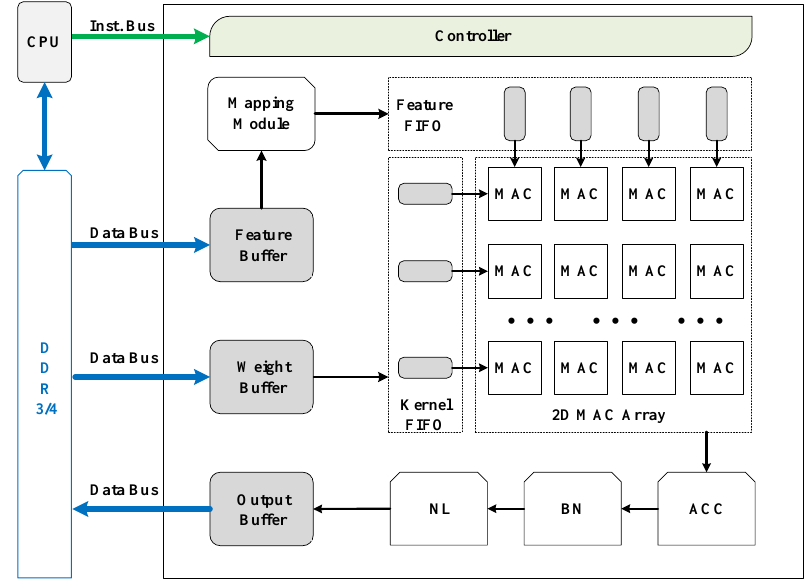
Figure 5. Our proposed uniform accelerator architecture for 2D and 3D convolutional neural networks